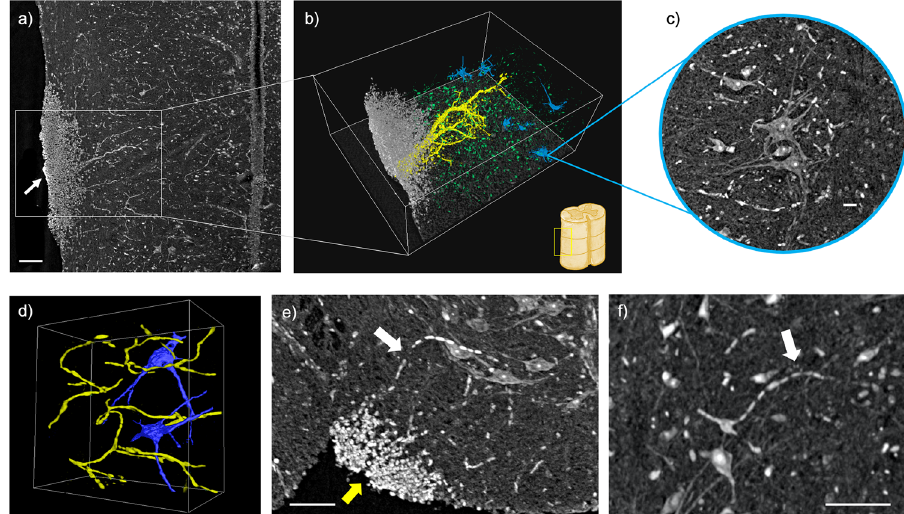
Fig. 2 Micro-environment of vascular lesions in lumbar spinal cord. High-resolution X-ray phase contrast tomography (XPCT) describes the micro- environment of vascular lesions in lumbar spinal cord of an experimental autoimmune encephalomyelitis (EAE)-induced mouse at disease onset. a XPCT image showing a portion of the lumbar spinal cord in coronal view. The arrow highlights the presence of a lesion with a large accumulation of cells around vessels. Scale bar = 50 μ m. b 3D-rendering of the micro-environment around the vascular lesion. The features are segmented with different colors: in white the small cells surrounding the vessel (yellow), in green and blue morphologically neuron-like cells. Inset: schematic representation of the localization of the vascular lesion of ( a ) and ( b ) in the spinal cord. The image was obtained by reprocessing the data used to produce a fi gure from our recent work 21 . c XPCT image of star-shaped cells located in the anterior horn of EAE-induced mouse, compatible with neurons provided with processes, dendrites, or axons. Scale bar = 25 μ m. d 3D-rendering of star-shaped cells (blue) surrounded by capillaries (yellow). e , f XPCT images with well-visible dashed structures (white arrows) compatible with axons wrapped by myelin sheath (scale bar = 50 μ m). In ( e ), near the lesion (yellow arrow) the dashed structure seems to lose its periodicity and to become less bright (white arrow). Clinical EAE score at the onset = 1.5. Images a – c , e , f were obtained as maximum intensity projections